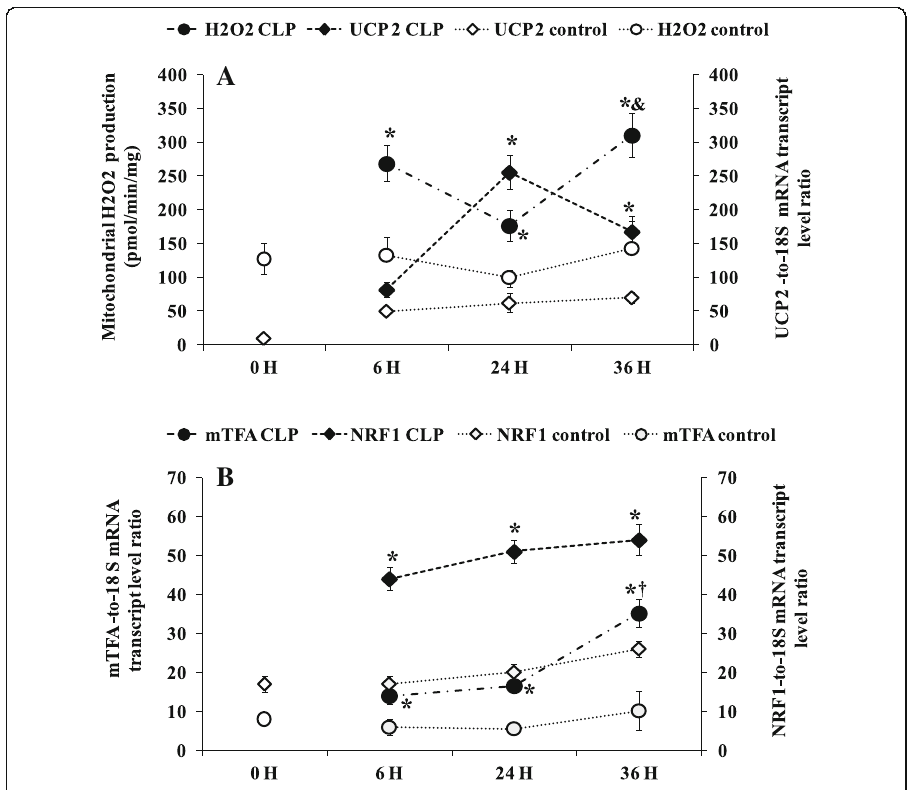
Fig. 5 a Relation between liver uncoupling protein 2 (UCP 2) mRNA gene expression and liver mitochondrial H 2 O 2 production. UCP 2 mRNA was determined by real-time quantitative PCR in the liver of control groups (naïve and sham-operated) (white symbols) and CLP groups (black symbols). Data are means± SEM. * p <0.05 versus sham-operated and naïve rats; & p <0.05 compared 24 h CLP and 36 h CLP, from five animals per group determined by surgical procedure and following period (0, 6, 24, 36 h). Mitochondrial H 2 O 2 production was measured in the presence of succinate without rotenone. * p <0.05 versus sham-operated and naïve rats; & p <0.05 compared 24 h CLP and 36 h CLP, from six animals per group determined by surgical procedure and following period (0, 6, 24, 36 h). b Mitochondrial transcription factor A (mTFA) and nuclear respiratory factor 1 (NRF 1) mRNA level were determined by real-time quantitative PCR in the liver of control groups (naïve and sham-operated) (white symbols) and CLP groups (black symbols). Data are means±SEM. * p <0.05 versus sham-operated and naïve rats and † p <0.05 compared 6 h CLP and 36 h CLP, from five animals per group determined by surgical procedure and following period (0, 6, 24, 36